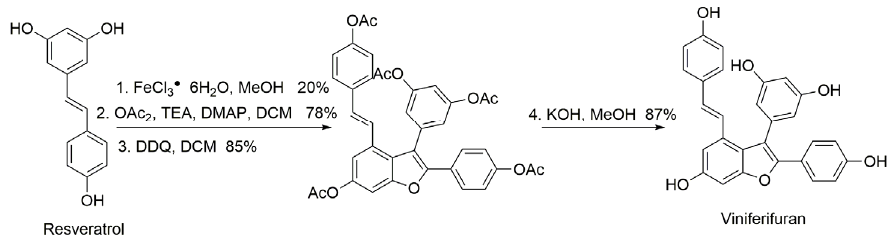
Figure 12. The synthesis route of viniferifuran.